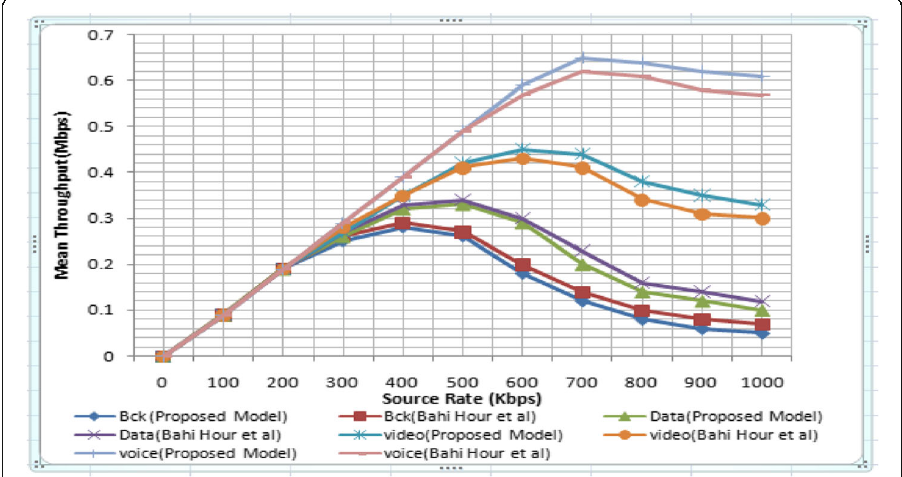
Fig. 10 Impact of network load on throughput for model and